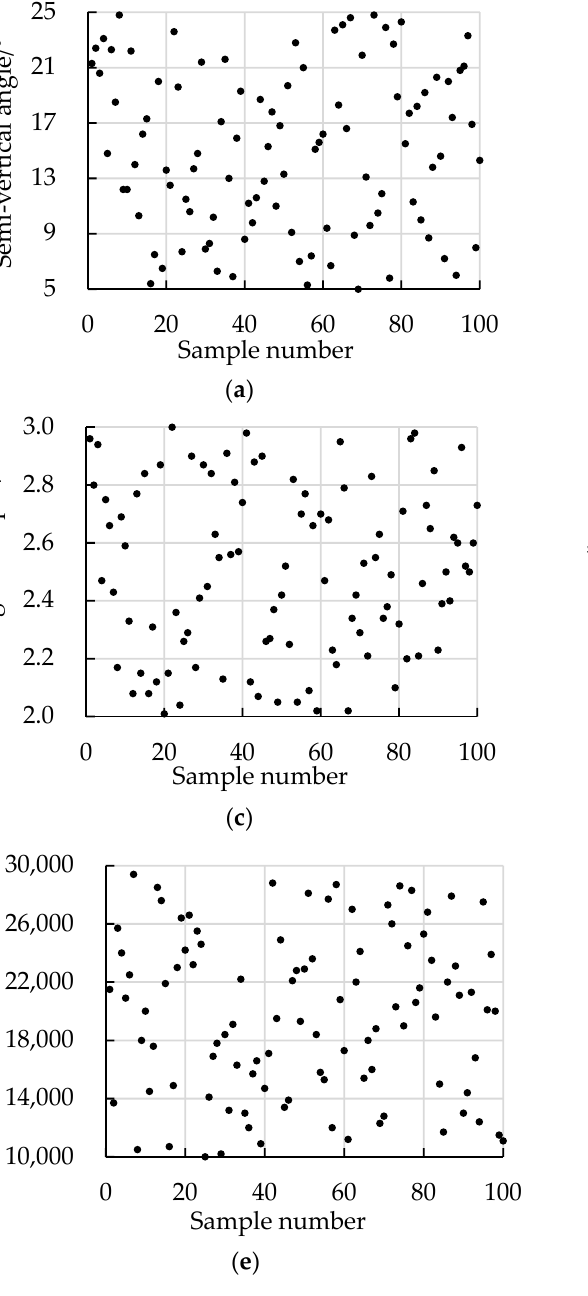
Figure 2. Sample scatter diagrams. ( a ) semi-vertical angle; ( b ) radius; ( c ) submergence depth; ( d ) mass; ( e ) damping; ( f ) stiffness.